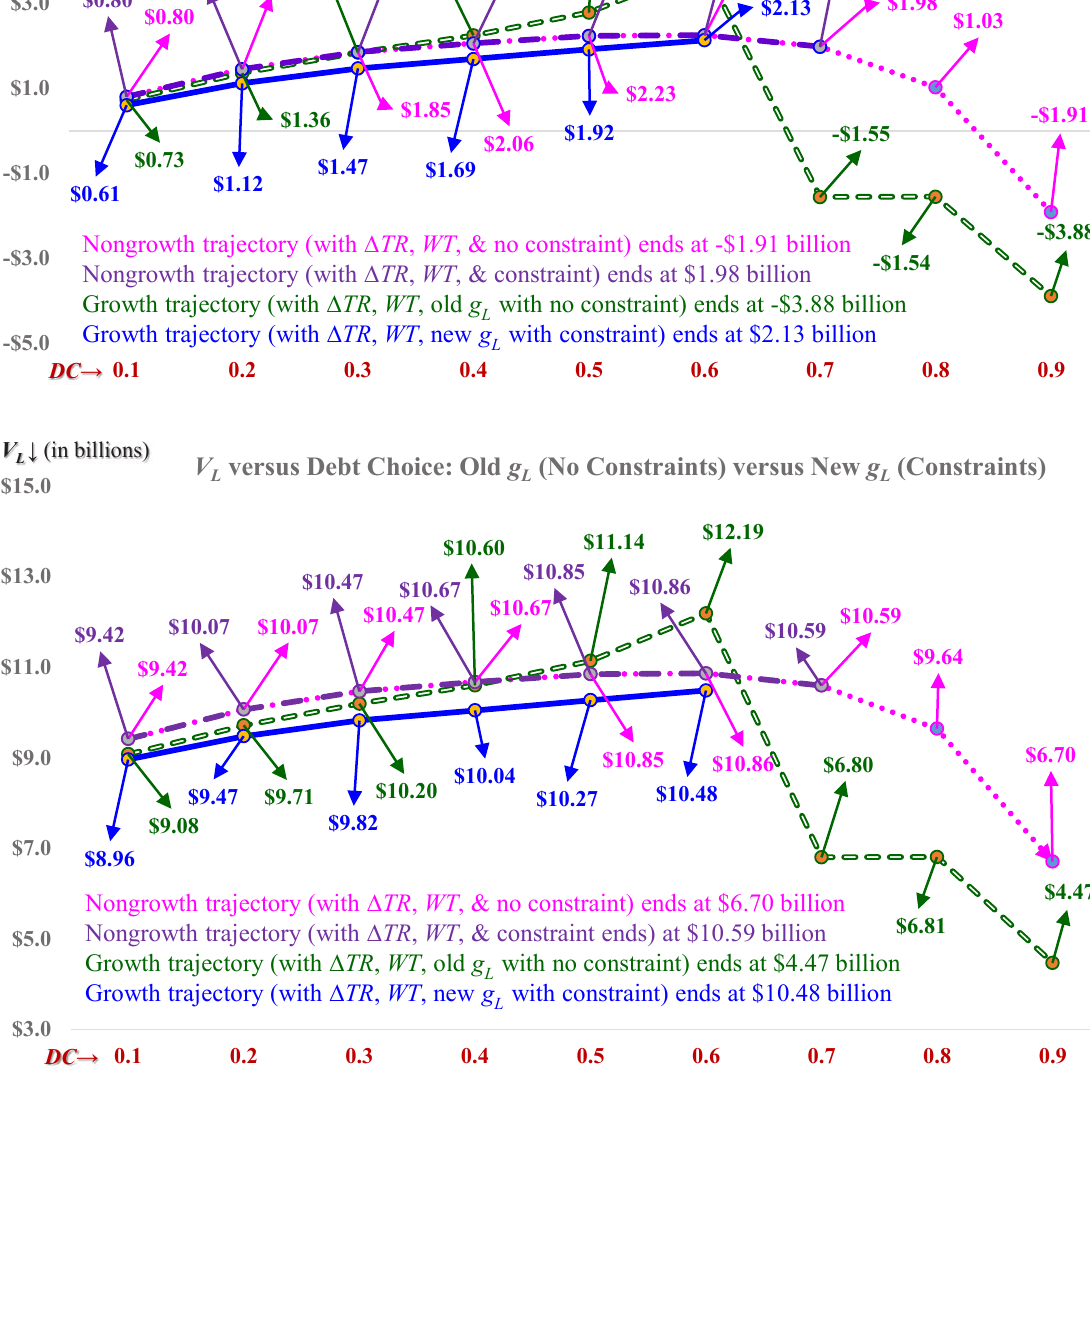
(No Constraints) versus New g L